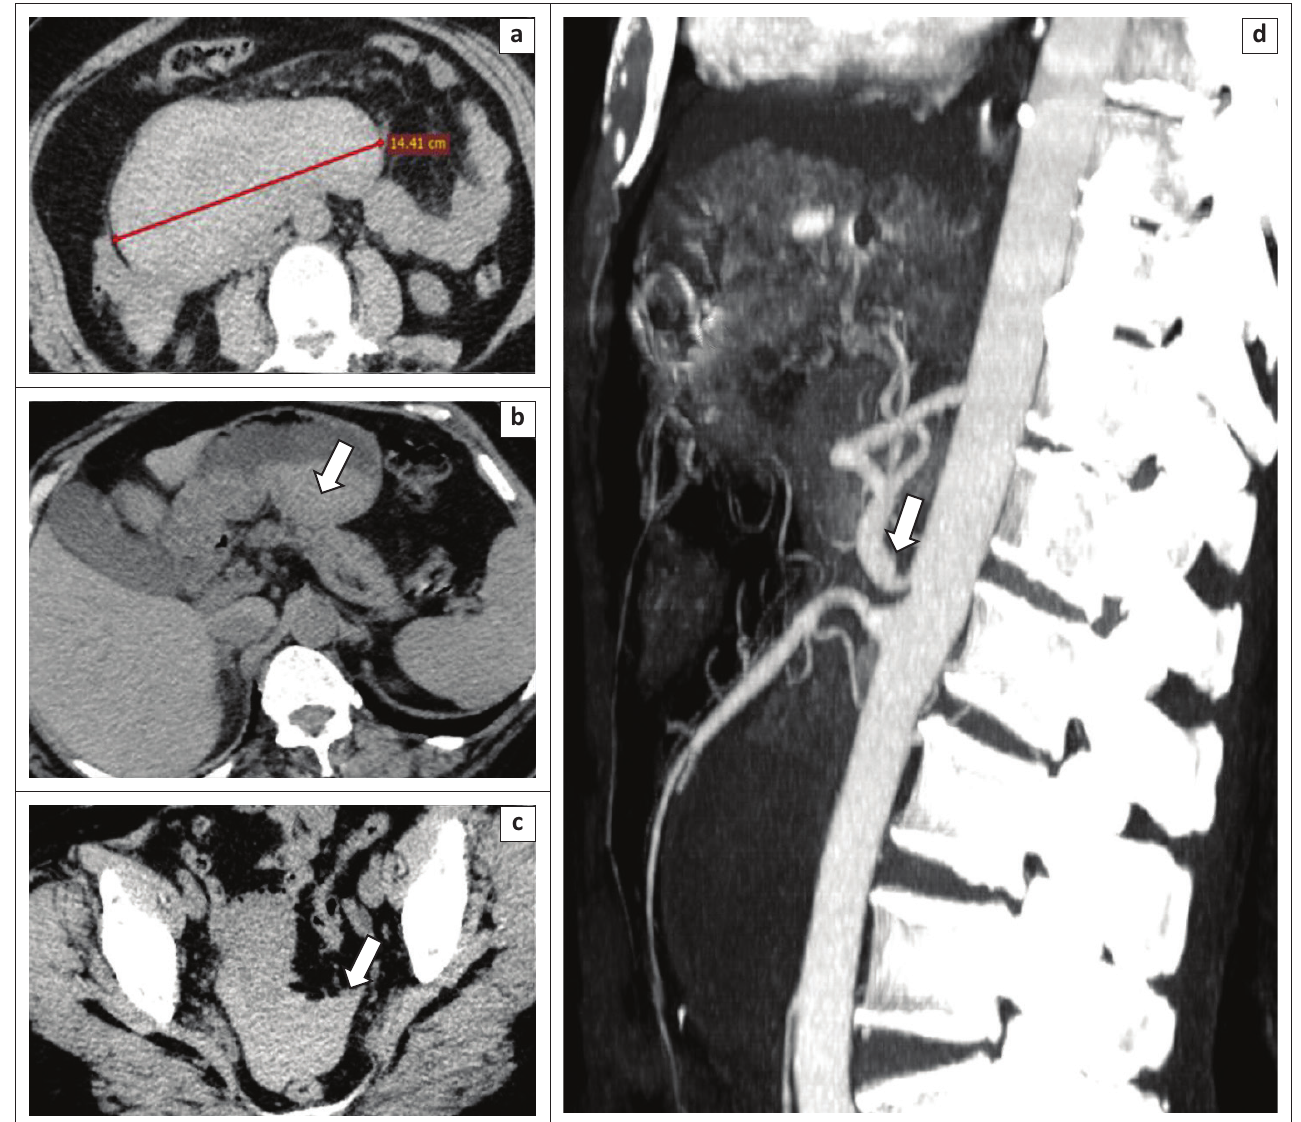
FIGURE 2: A 64-year-old woman with persistent diffuse abdominal pain, admitted for haematemesis and melena. Axial non-enhanced computed tomography demonstrates a homogeneous hyperdense haematoma of approximately 14 cm (a), haemorrhage within the stomach (arrow, b) and haemoperitoneum (arrow, c). Arterial phase sagittal reconstruction (d) demonstrates moderate coeliac artery compression by the median arcuate ligament with no visible pancreatico-duodenal artery